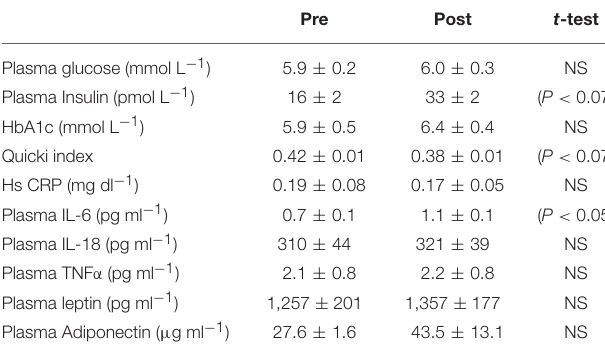
TABLE 2 | Plasma glucose, insulin and Quicki-index as well as plasma cytokines, TABLE 1 | Anthropometric and body composition data measured at rest hsCRP and adiponectin and leptin measured at rest overnight fasted before and overnight fasted before and after 14 days of daily prolonged cycling. after 14 days of daily prolonged cycling in 6 older Pre Post t -test